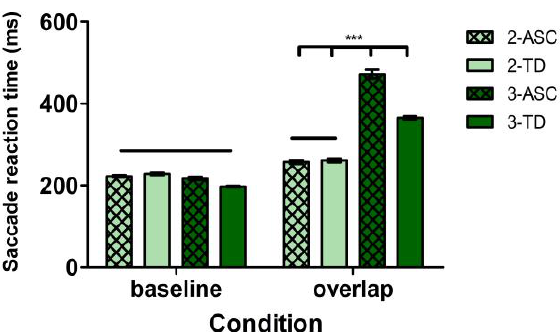
Figure 6. Mean SRT for each group in both Experiment 2 and Experiment 3. Error bars represent standard errors. *** p < 0.001.